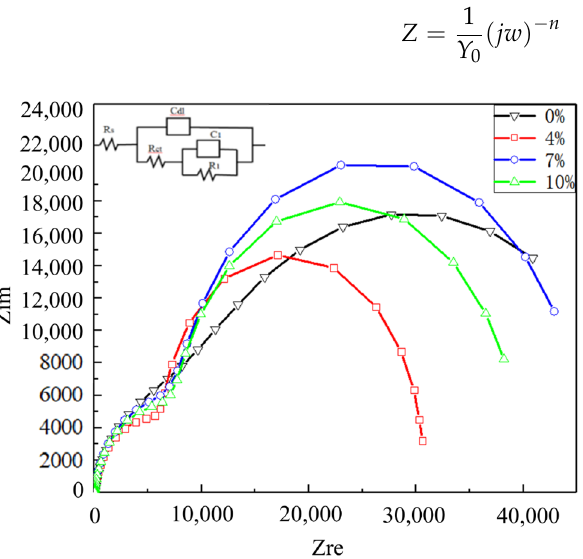
Figure 7. Nyquist results from the EIS test of the 2024 FSWed joints with different deformations in the 3.5% NaCl electrolyte.